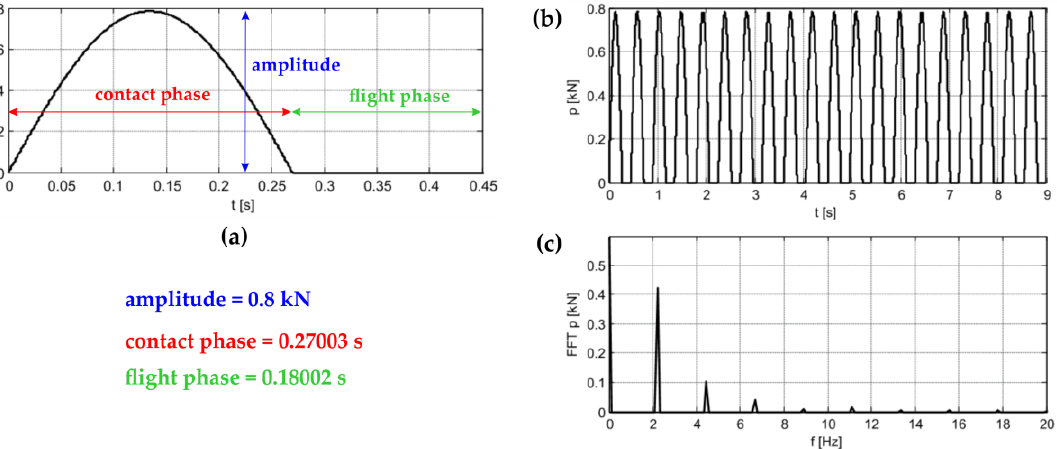
Figure 14. Labado function: ( a ) one jump, ( b ) 20 jumps, ( c ) Fourier transformation of the Labado function .